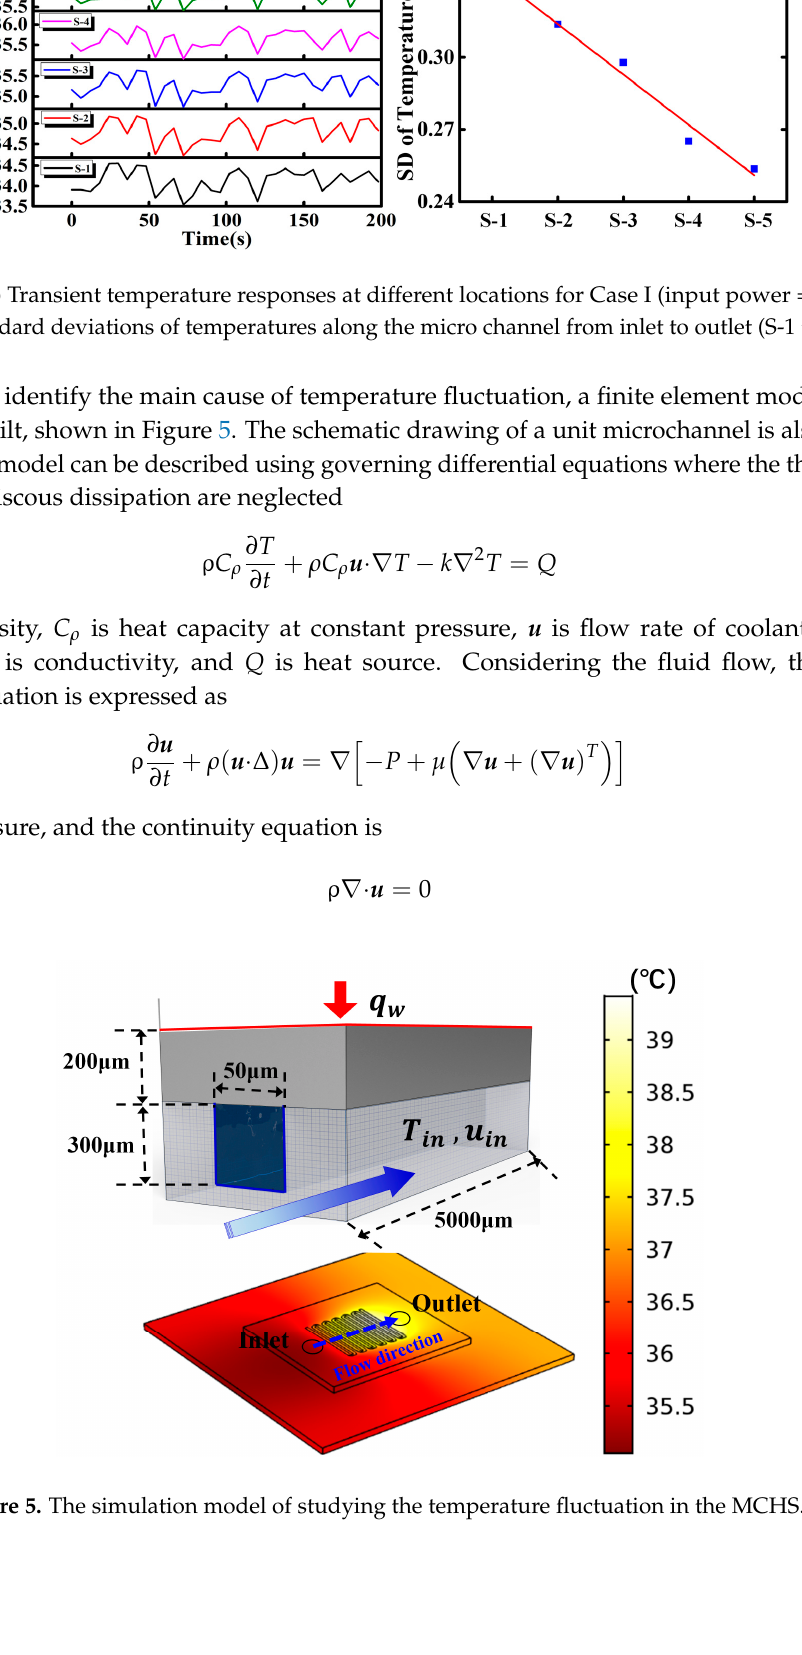
Figure 5. The simulation model of studying the temperature fluctuation in the MCHS.